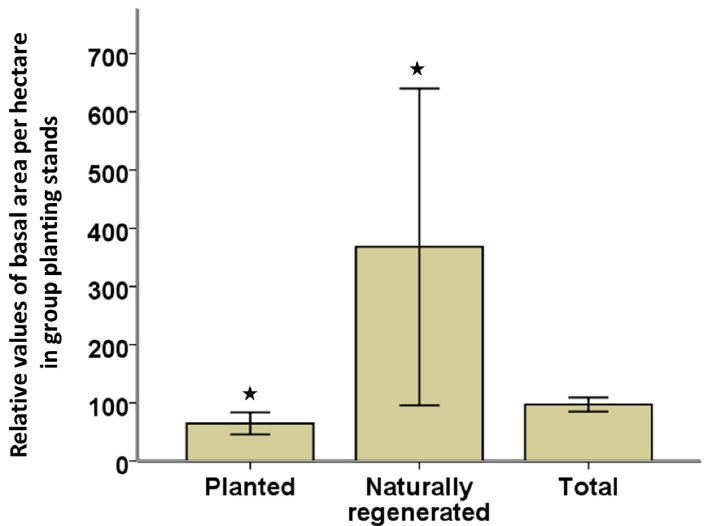
Figure 4. Percent basal area of planted, naturally regenerated and total number of trees in group planting compared to row planting. A value of 100 means no difference in basal area between group and row planting. The bars represent standard error at the level of 95% confidence ( n = five pairs of group and row planting stands). Stars denote a significant difference in mean basal area per hectare between group and row planting stands.